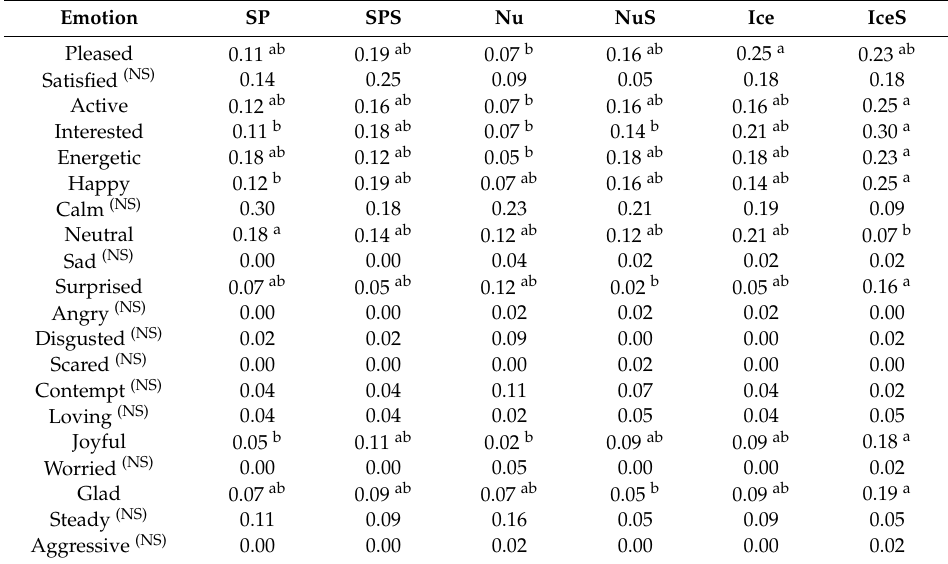
Table 5. Frequency of selection of the emotion-terms from the check all that apply sensory response for fizzing sound assessment. Di ff erent letters denote significant di ff erences between samples assessed using Cochran Q and pairwise comparison tests [19].